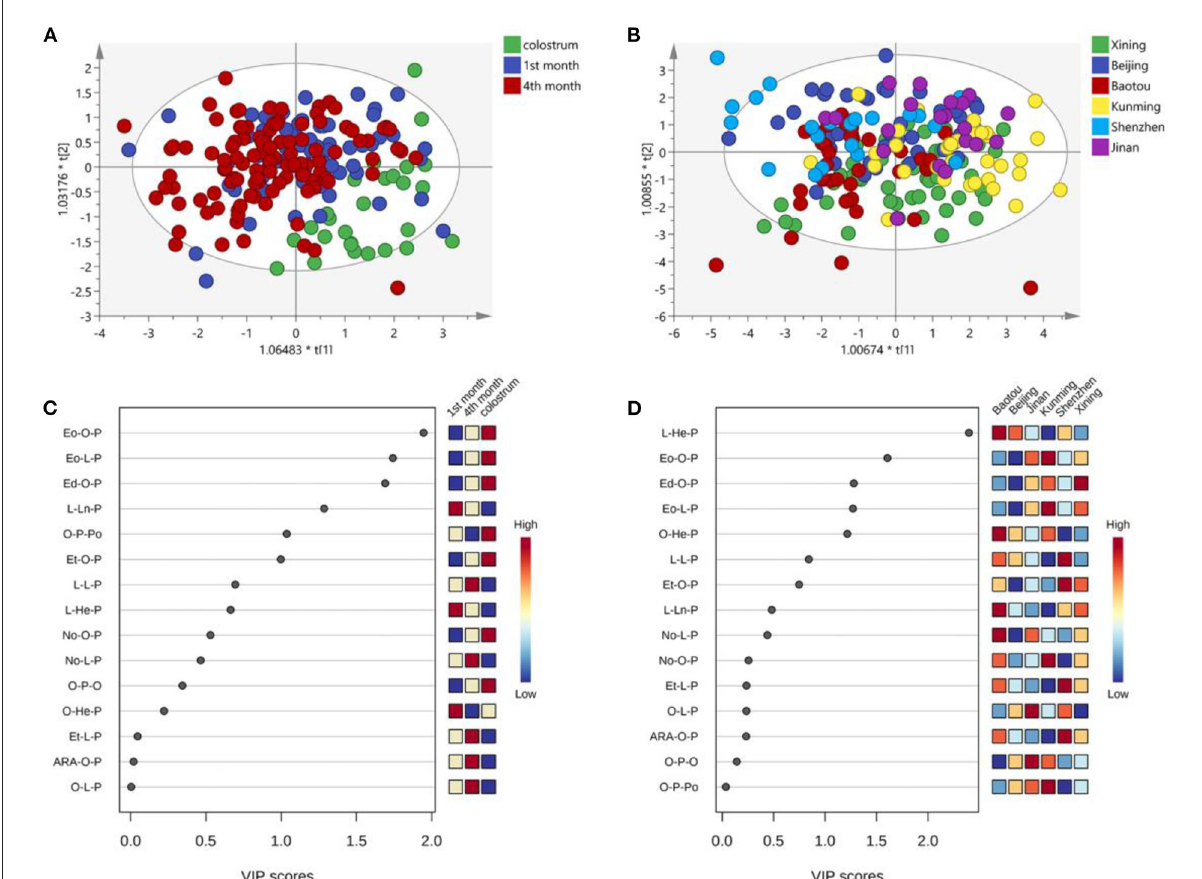
FIGURE4 OPLS-DA analysis of UPU types TAG across the lactation stage (A) and cities (B) ; VIP scores plot for cluster analysis of UPU molecules across the lactation stage (C) and cities (D) .